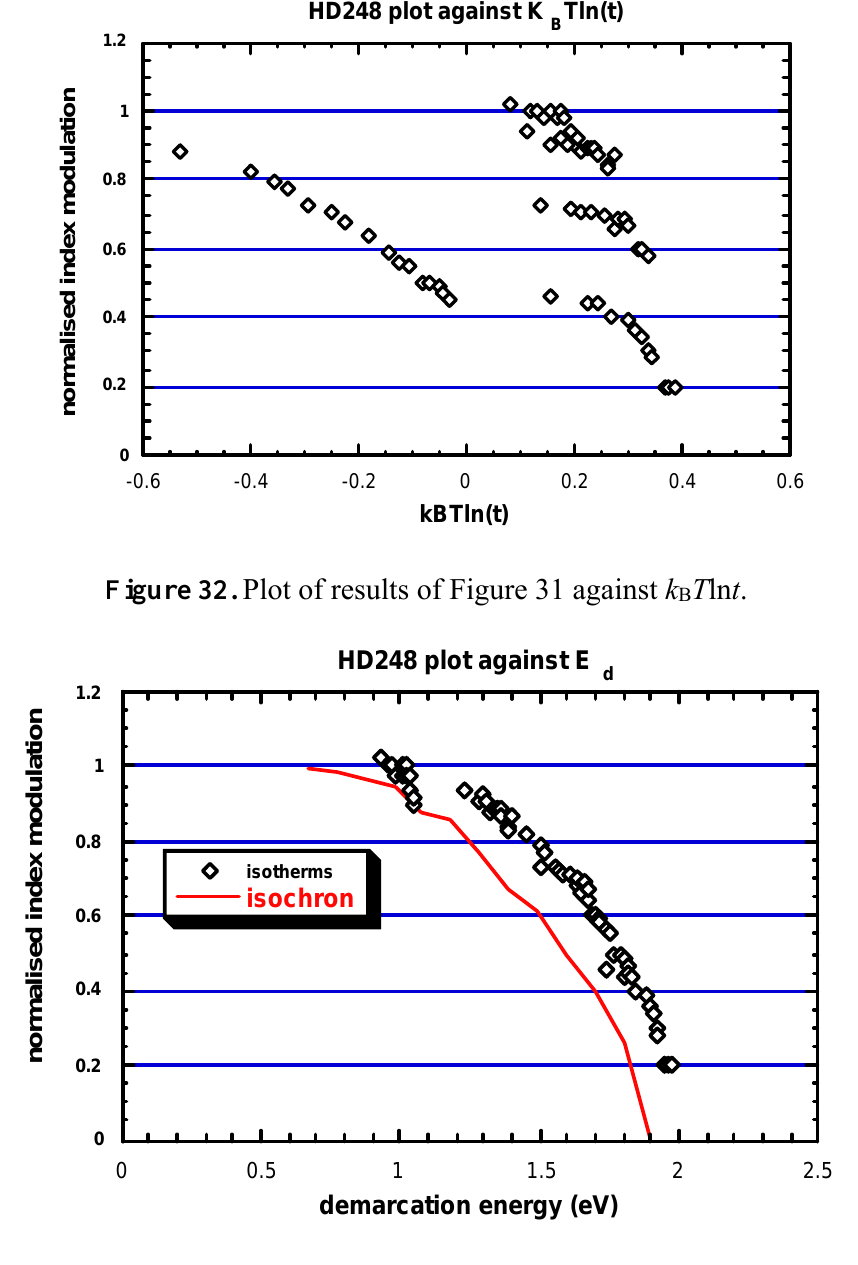
Figure 33. Plot against demarcation energy, an isochron has been